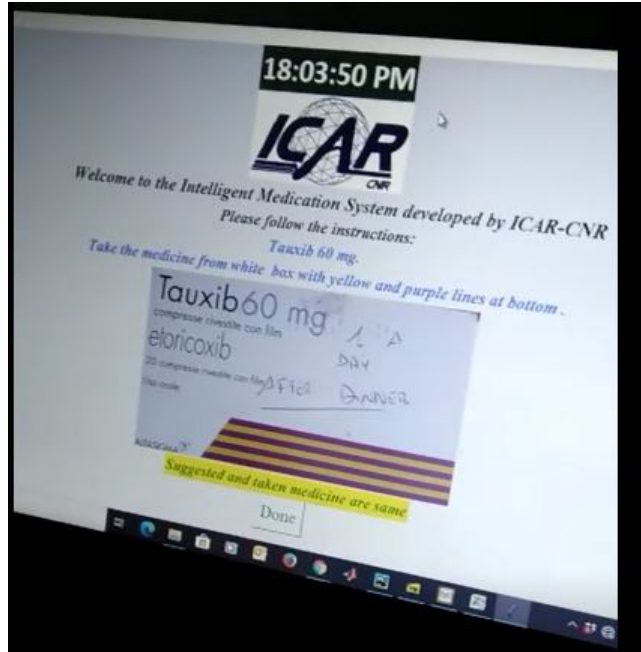
Figure 8. GUI demonstration-4.